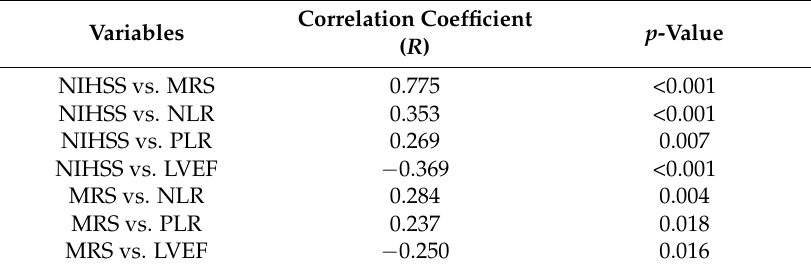
Table 3. Correlation of NLR, PLR and LV systolic function to stroke severity (MRS and NIHSS). Correlation Variables